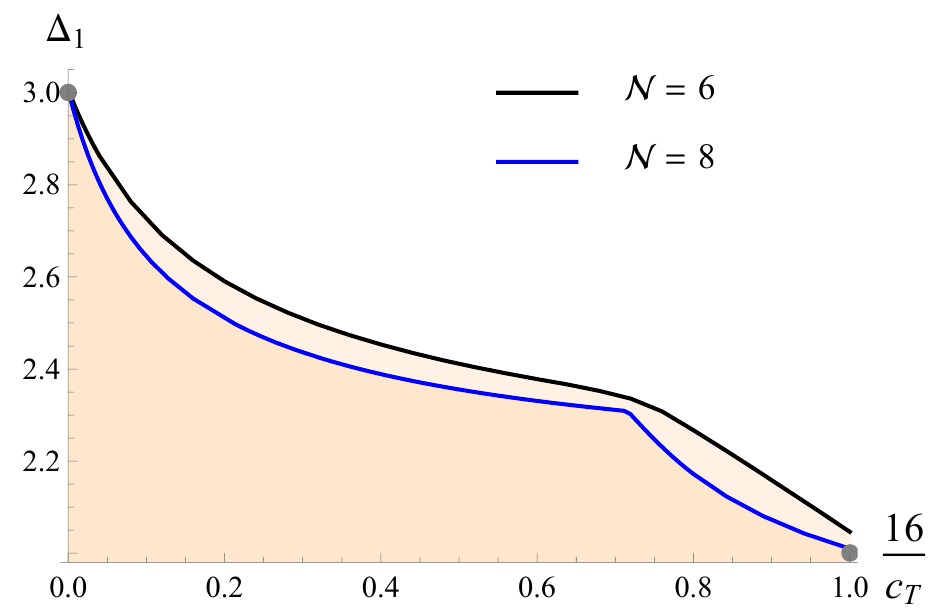
Figure 4 . Upper bounds on the scaling dimension of the lowest dimension ‘ = 1 long multiplet (which has a unique superconformal structure) in terms of c T , where the orange shaded region is allowed, and the plot ranges from the GFFT limit c T → ∞ to the free theory c T = 16 . The black line denotes the N = 6 upper bound computed in this work with Λ = 39 , the blue line denote the N = 8 upper bound computed in [10] with Λ = 43 . The gray dots denote the GFFT and free theory values from table